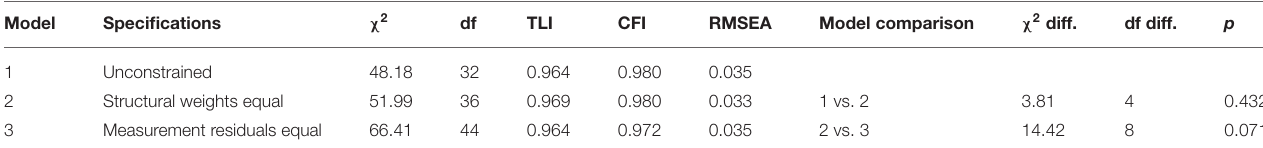
TABLE 4 | Multi-group analysis: boys vs. girls.